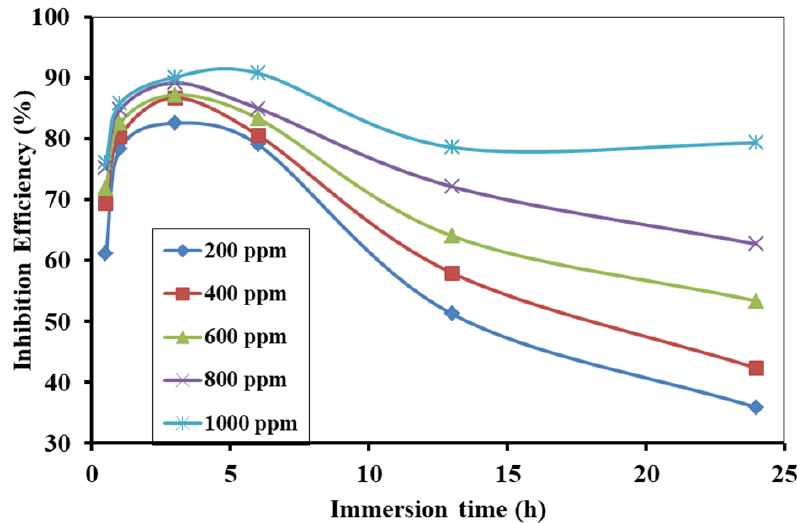
Figure 9. Inhibition efficiency of ST alkaloids for mild steel immersed at different intervals of time.